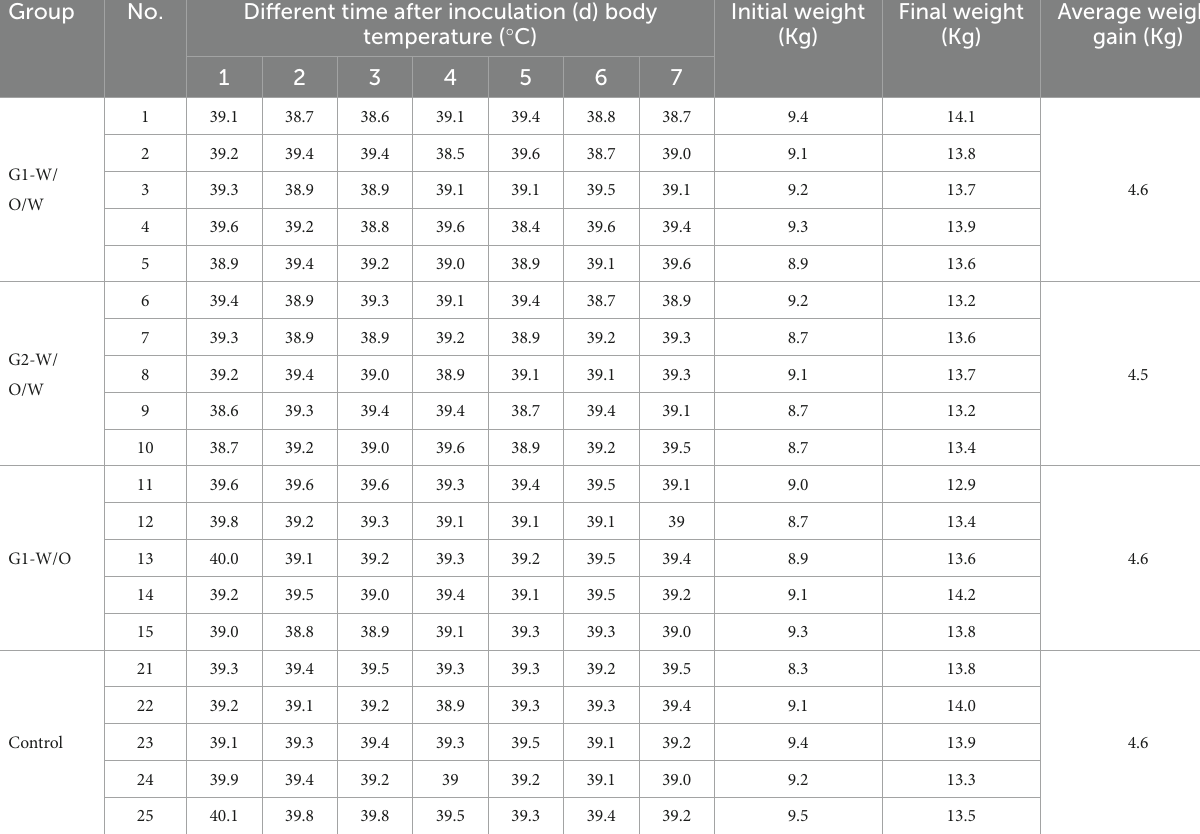
TABLE 2 Safety test results of one-time overdose vaccination for piglets.